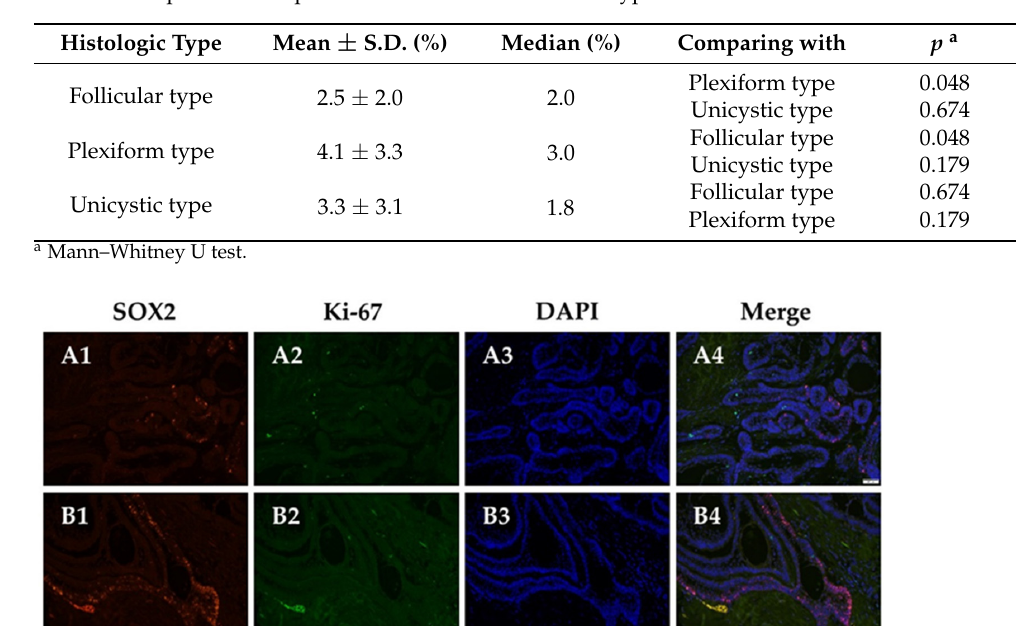
Table 5. Comparison of expression status of Ki-67 in three types of ameloblastomas.